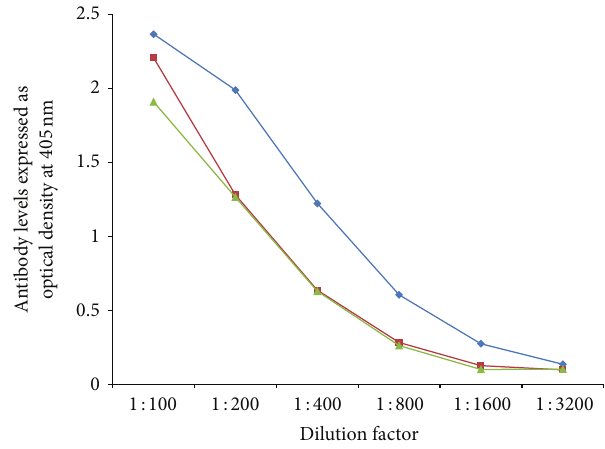
Figure 6: Serial dilution of IgG (blue diamond), IgA (green trian- gle), and IgM (red square) antibody against tomato.